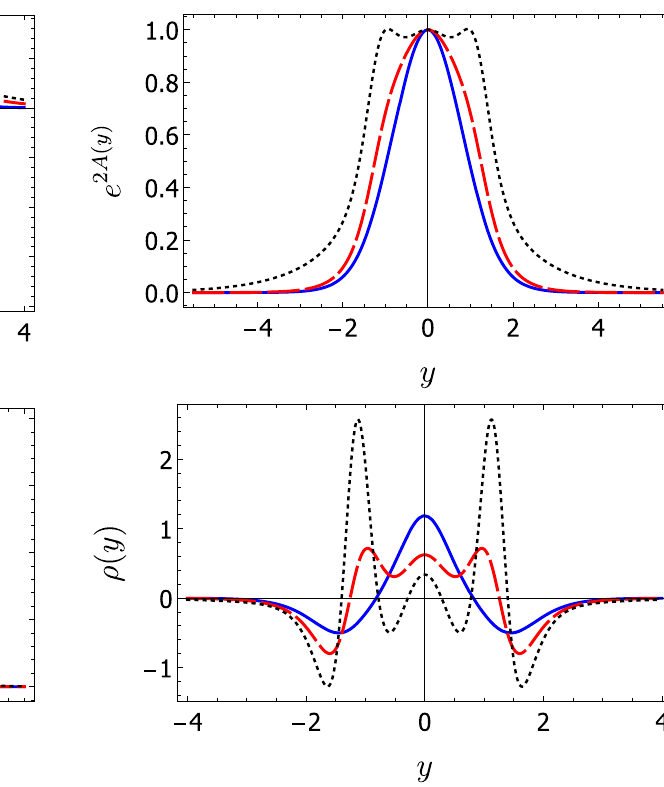
Fig. 4 Stability potential (top panel) and zero mode (bottom panel) depicted for c = 2 and α = 0 (solid-line), α = 2 . 4 (dashed-line) and α = 2 . 8 (dotted-line)